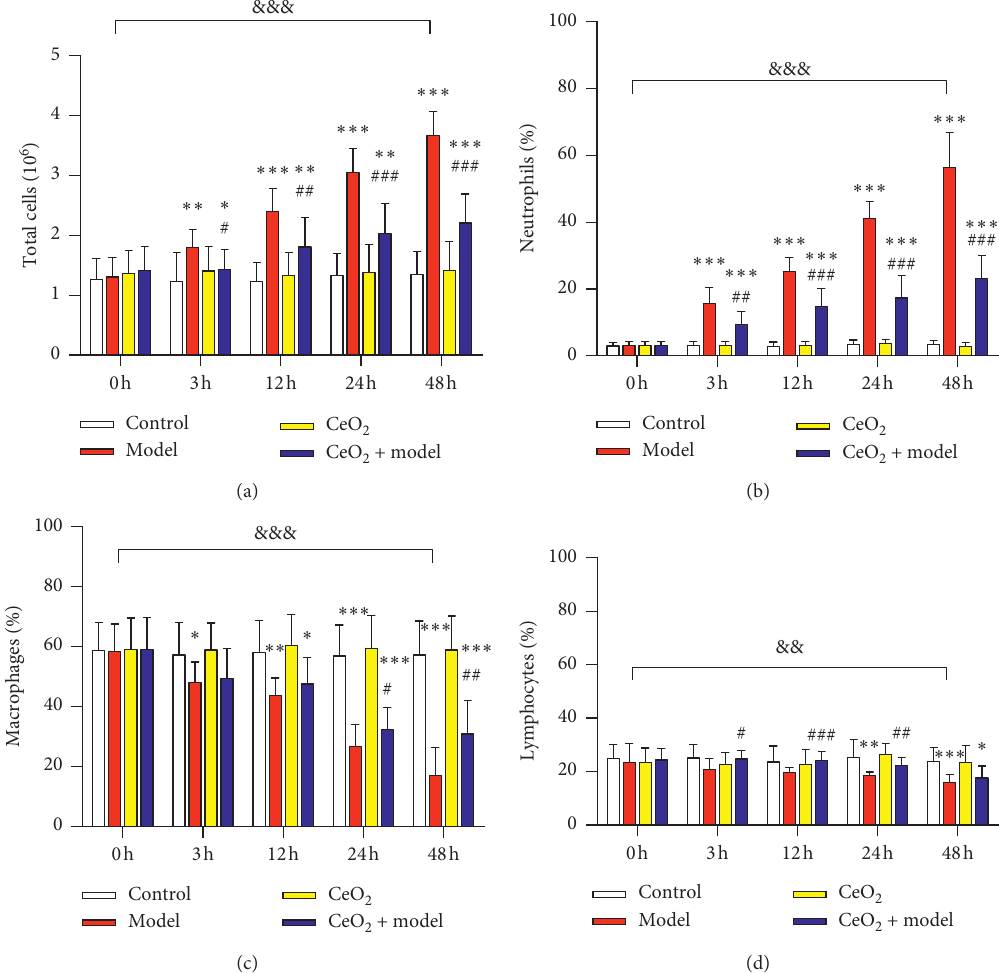
Figure 4: Differential counting of leukocytes in the peritoneal lavage fluid of each group of rats: (a) white blood cell count, (b) percentage of neutrophils, (c) percentage of macrophages, and (d) percentage of lymphocytes. Compared with the control group, ∗ P < 0 . 05, ∗∗ P < 0 . 01, ∗∗∗ P < 0 . 001; differences within the model group, && P < 0 . 01, &&& P < 0 . 001; compared with the model group, # P < 0 . 05, ## P < 0 . 01, ### P < 0 .